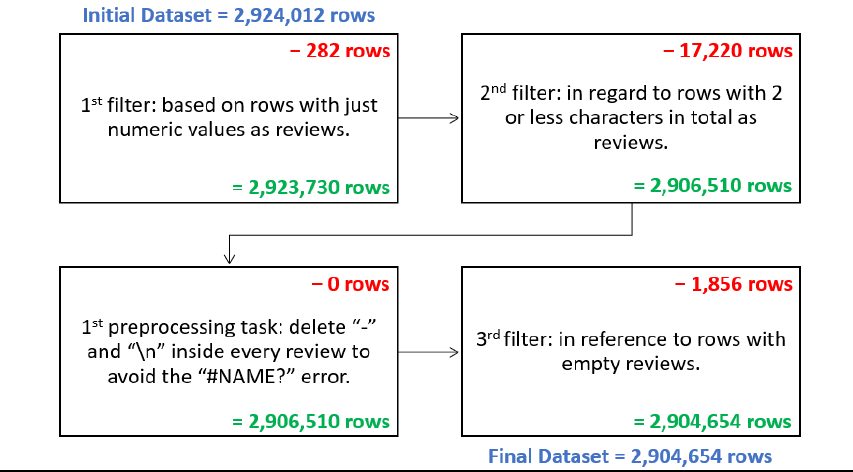
Figure 7. Complete view of the data cleaning process.